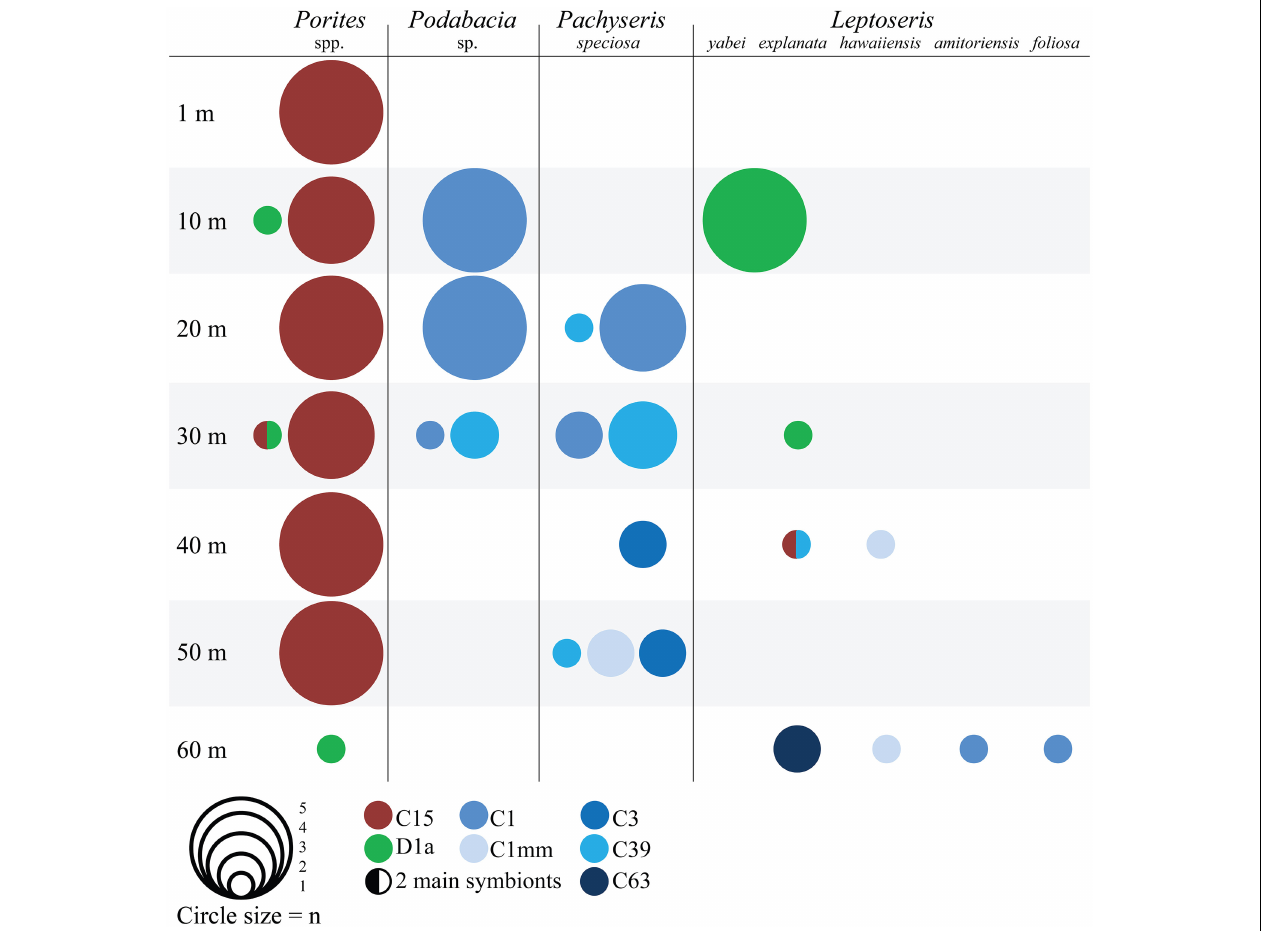
FIGURE 1 | Symbiodinium type association of different coral hosts over a 60m depth range in the central Red Sea. The size of the circles represents the number of sampled colonies (n) and the colors encode for Symbiodinium ITS2 types. Samples with two main symbionts have both